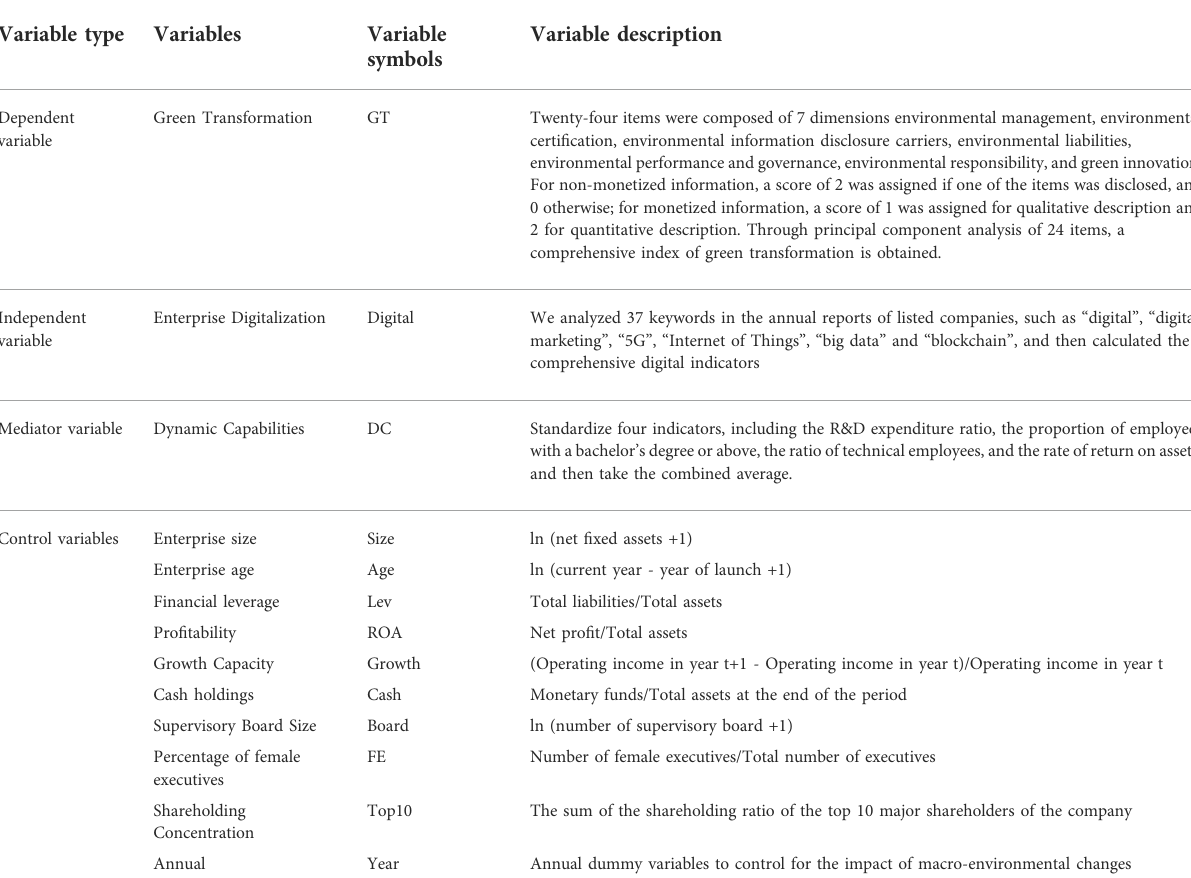
TABLE 2 Variables de fi